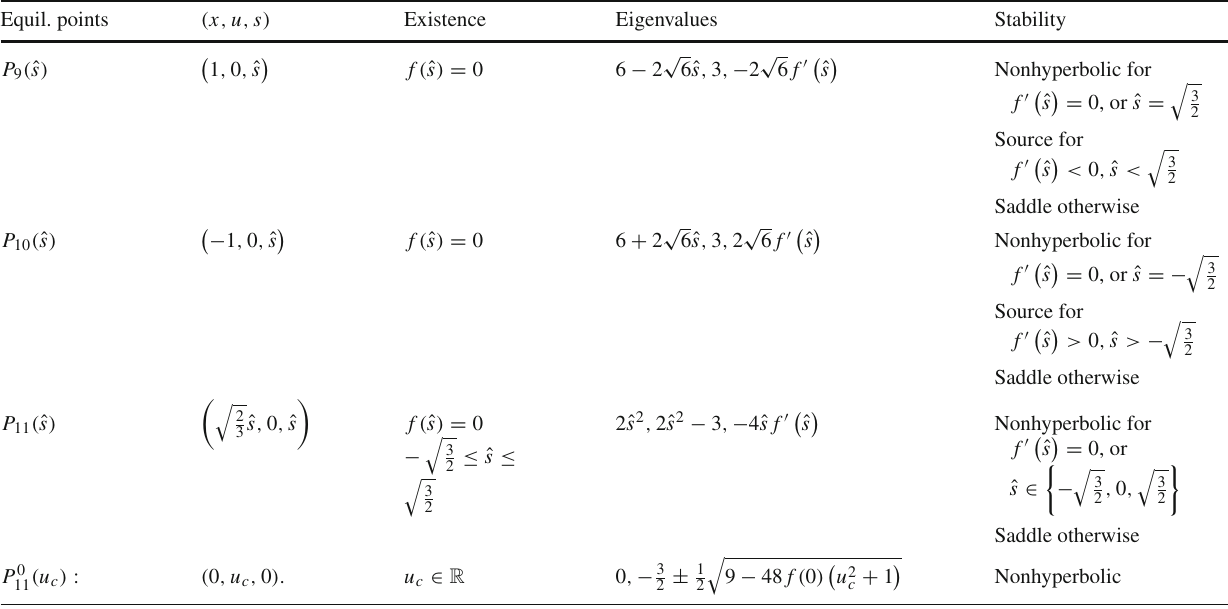
Table 5 Case 3: Equilibrium points at the finite region of the system (205), (206), (207) Equil. points ( x , u , s )